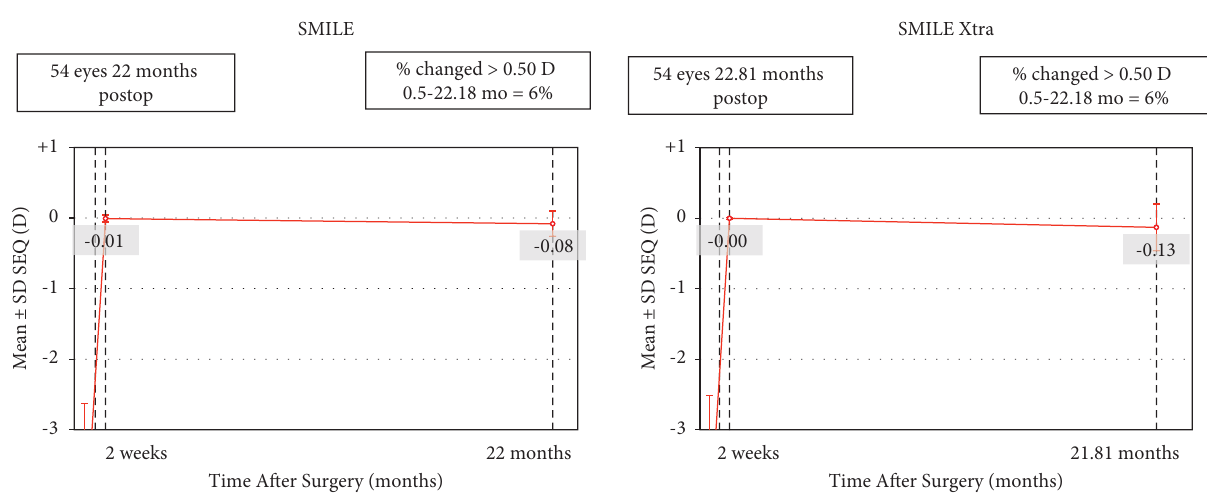
Figure 5: Histogram showing change in refractive astigmatism.